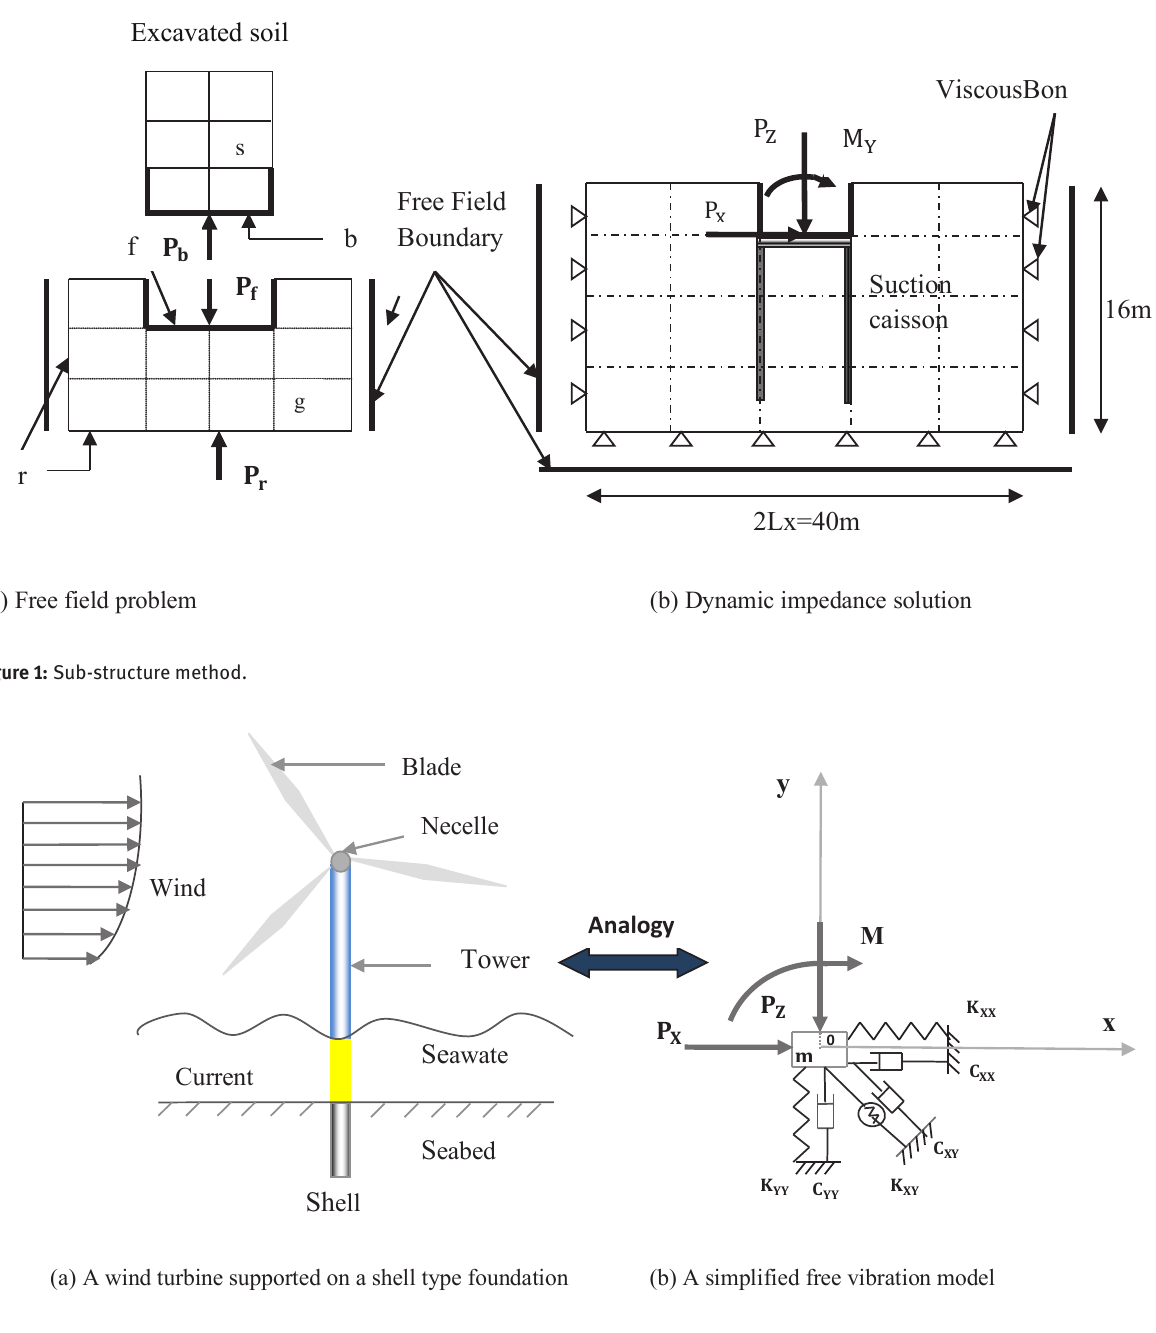
Figure 2: Impedance